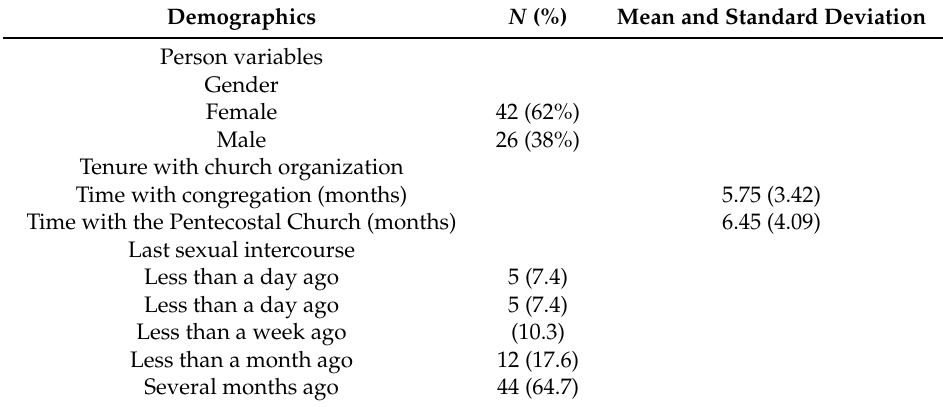
Table 1. Study sample characteristics ( N =